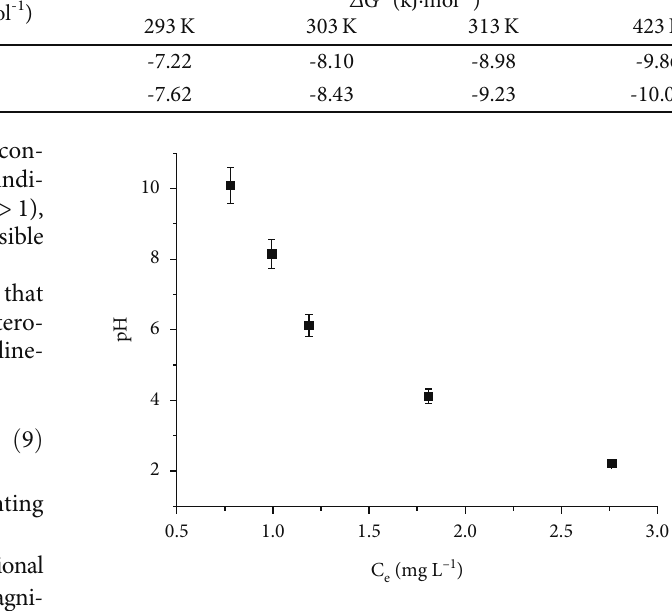
Figure 12: Concentrations obtained for desorbed BF dye at di ff erent initial solution pH